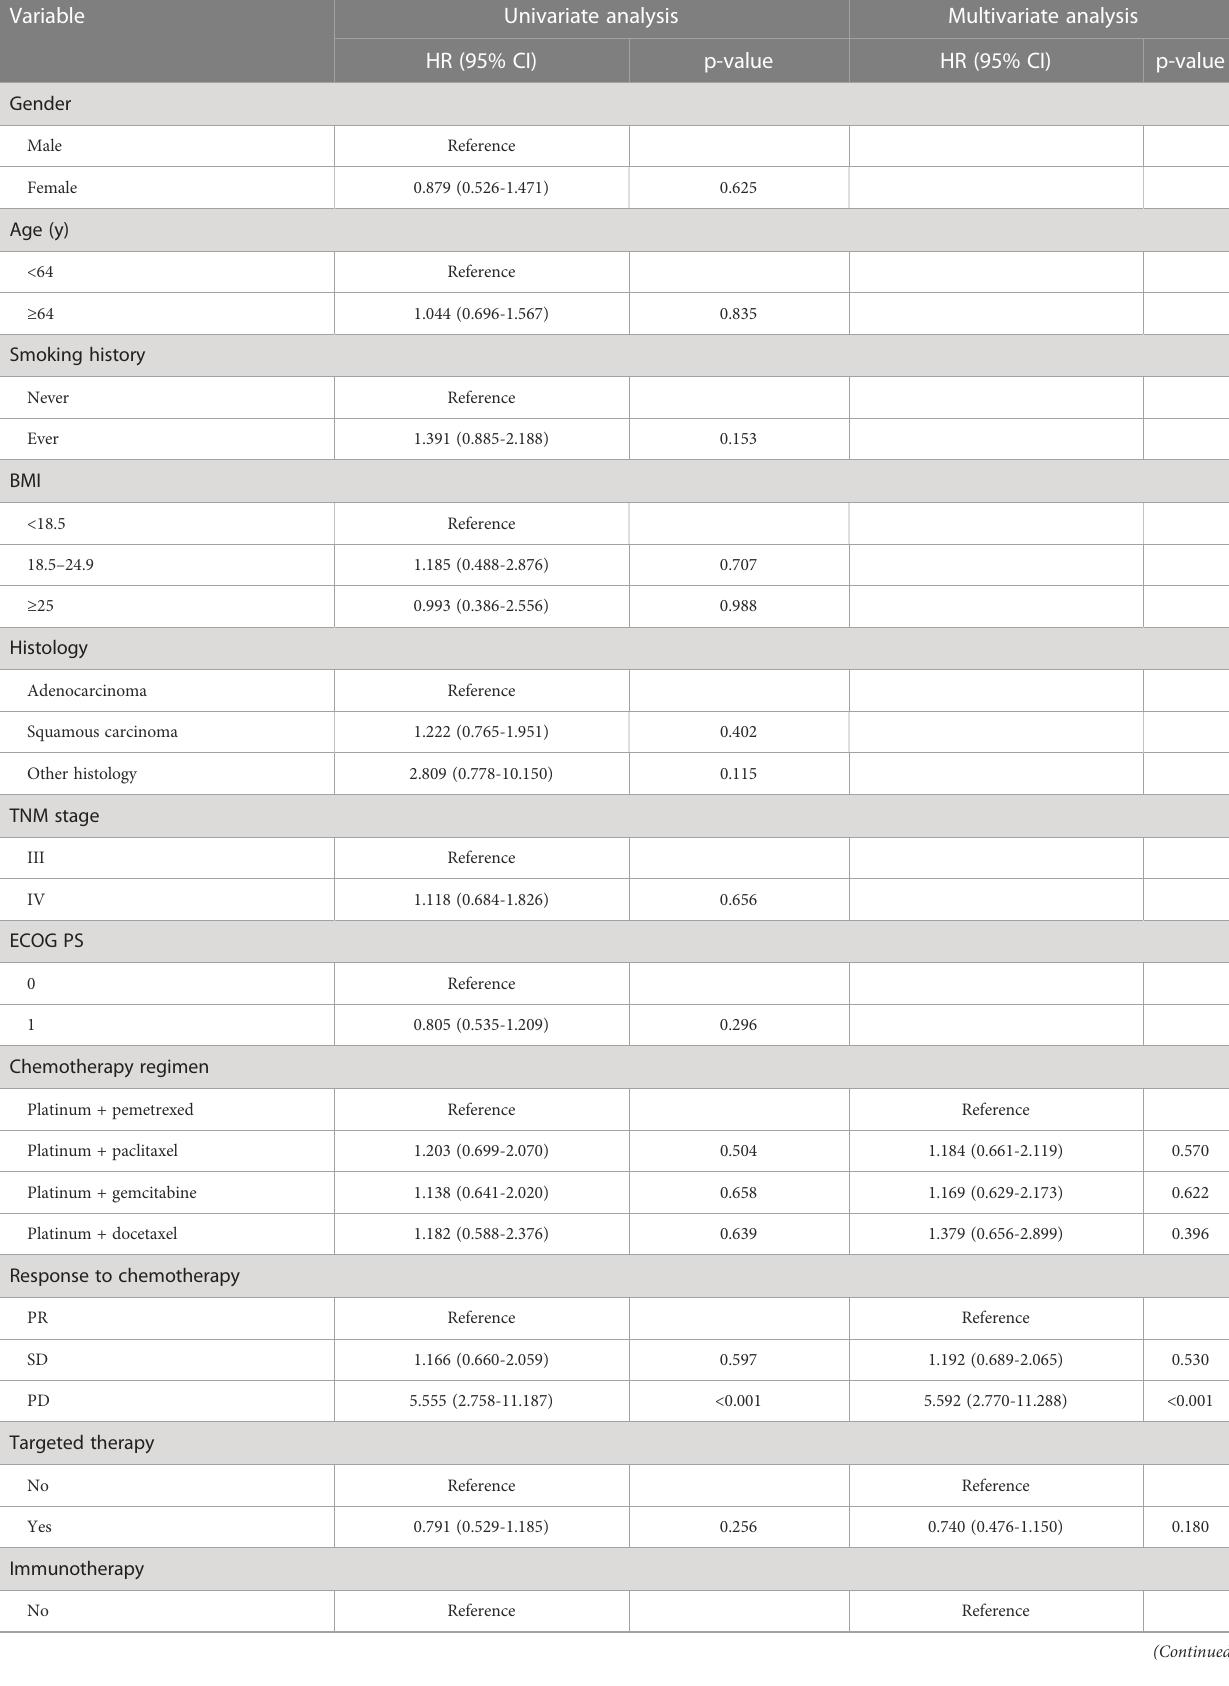
TABLE 3 Factors associated with progression-free